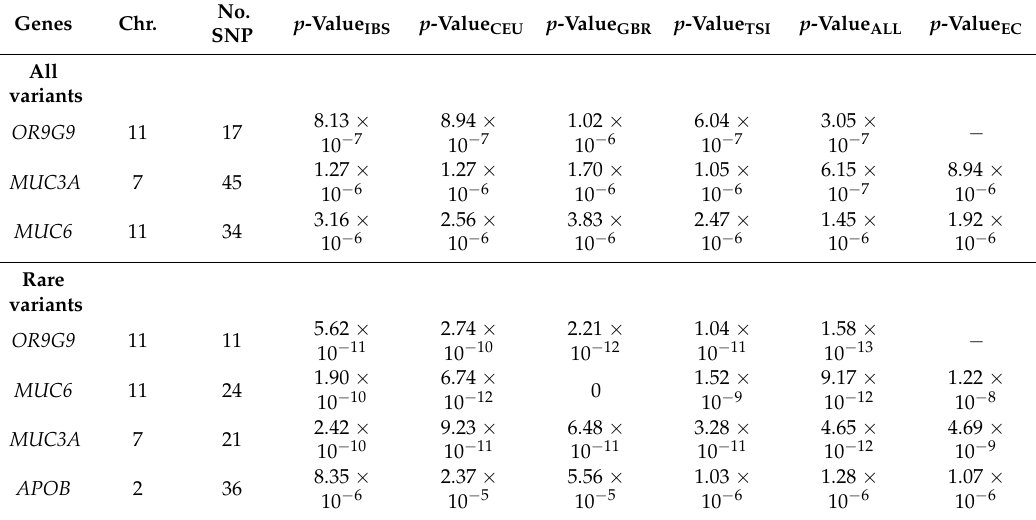
Table 4. Burden test of SNP considering all variants in genes and only those with low frequencies (MAF < 0.05 for the 1000G-IBS cohort). Average DANN per genes was used as covariant for the association test. The genes showing the lowest p -value against the 1000G-IBS control group were further tested in other control